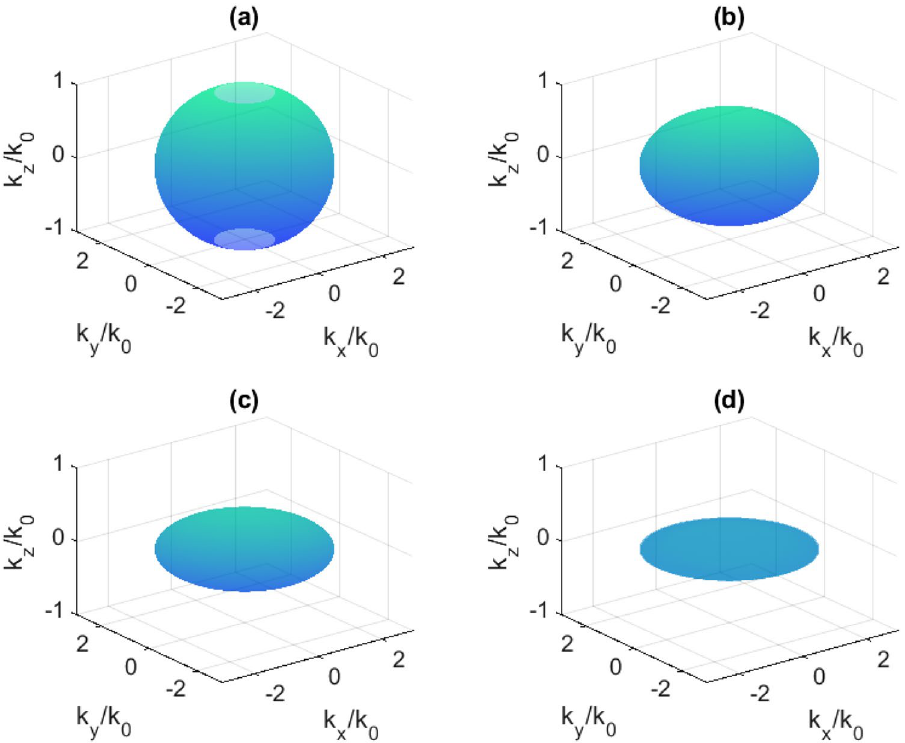
Figure 9. Isofrequency surfaces at 0.708 THz: ( a ) without pumping; ( b ) at 200 mW; ( c ) 400 mW; ( d ) 600